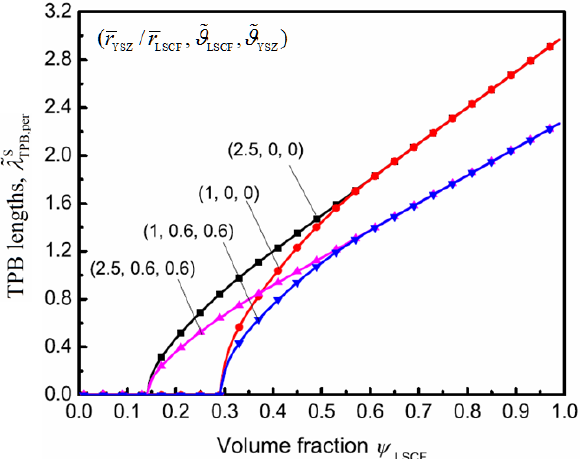
Figure 8. Dependence of the non-dimensional percolated TPB